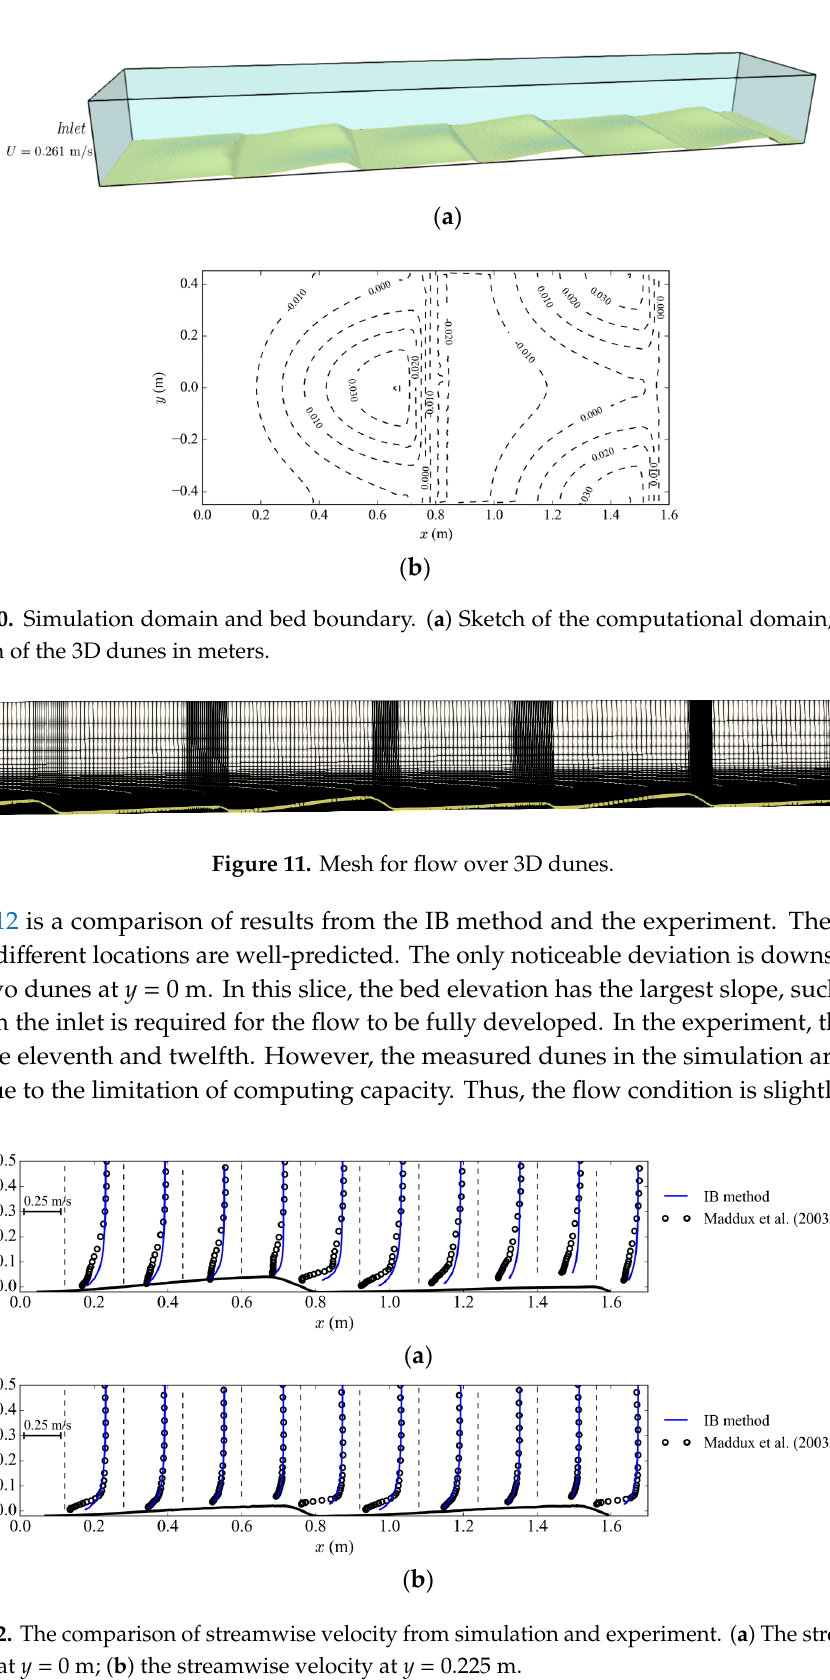
Figure 12. The comparison of streamwise velocity from simulation and experiment. ( a ) The streamwise velocity at y = 0 m; ( b ) the streamwise velocity at y = 0.225 m.